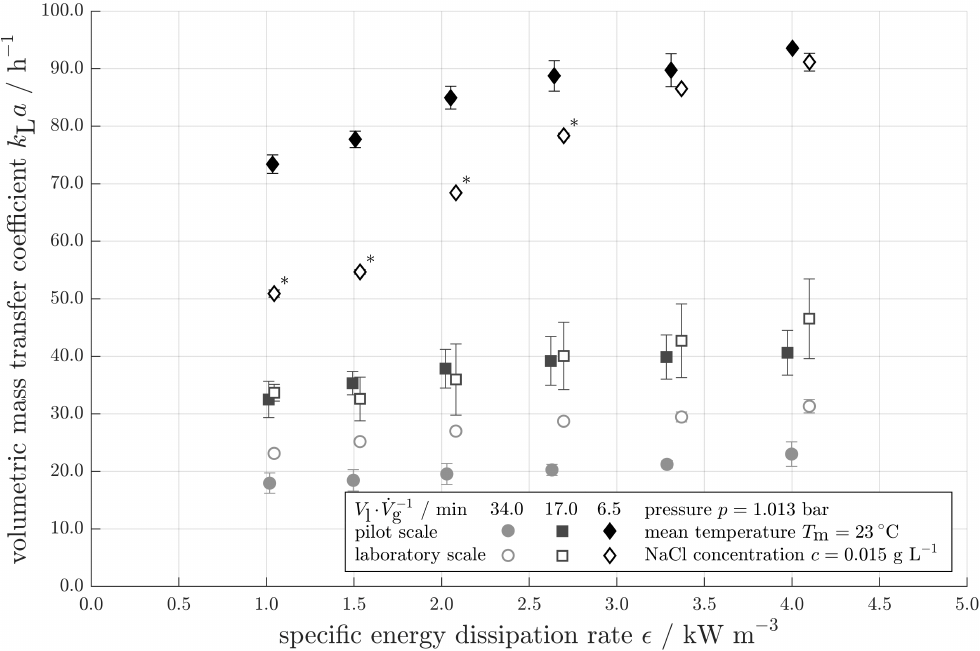
Figure 8. Comparison of determined volumetric mass transfer coefficients k L a in the pilot and laboratory setup for different gassing rates V l · ˙ V − 1 g at investigated specific energy dissipation rates (cid:101) . An asterisk (*) next to a data point denotes increased